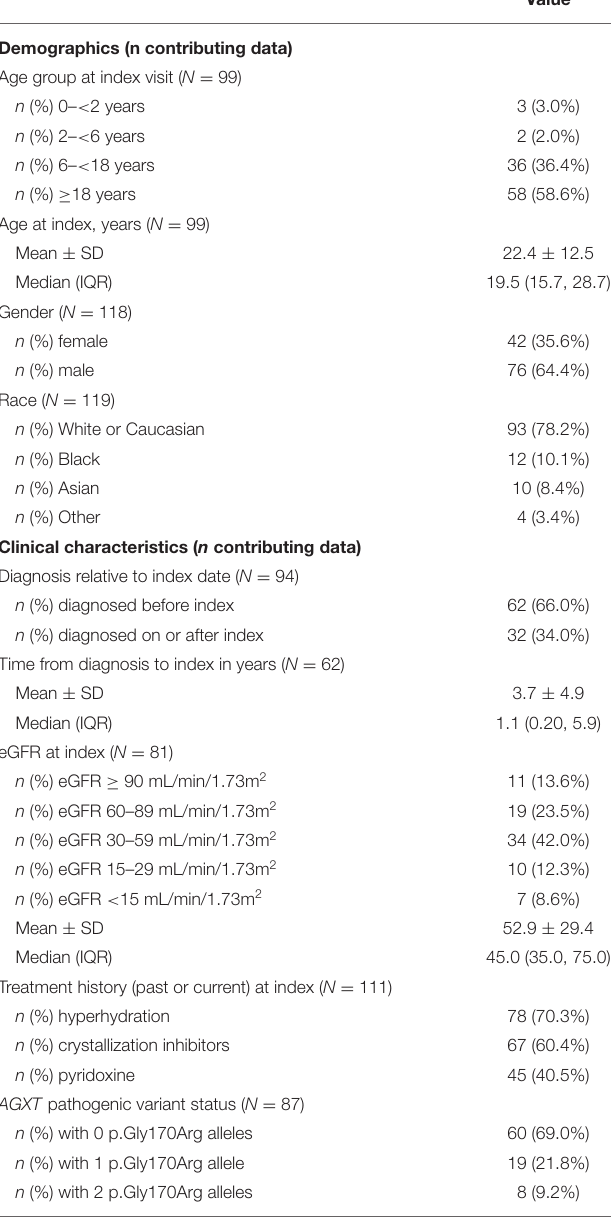
TABLE 1 | Baseline patient demographics and clinical characteristics.